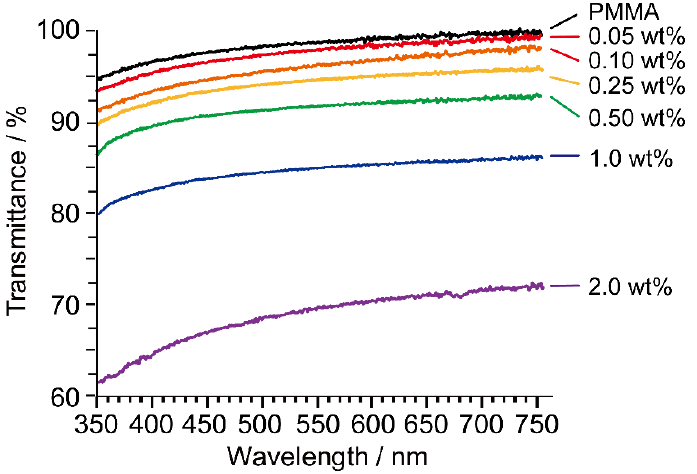
Figure 9. Photographic images of ~0.5 ‐ mm ‐ thick PMMA composite sheets containing 0.05, 0.10, 0.25, 0.50, 1.0, and 2.0 wt% MPC 1, with neat PMMA as a reference, overlaid on the periodic table. The perimeter of each sheet is indicated by a red circle.